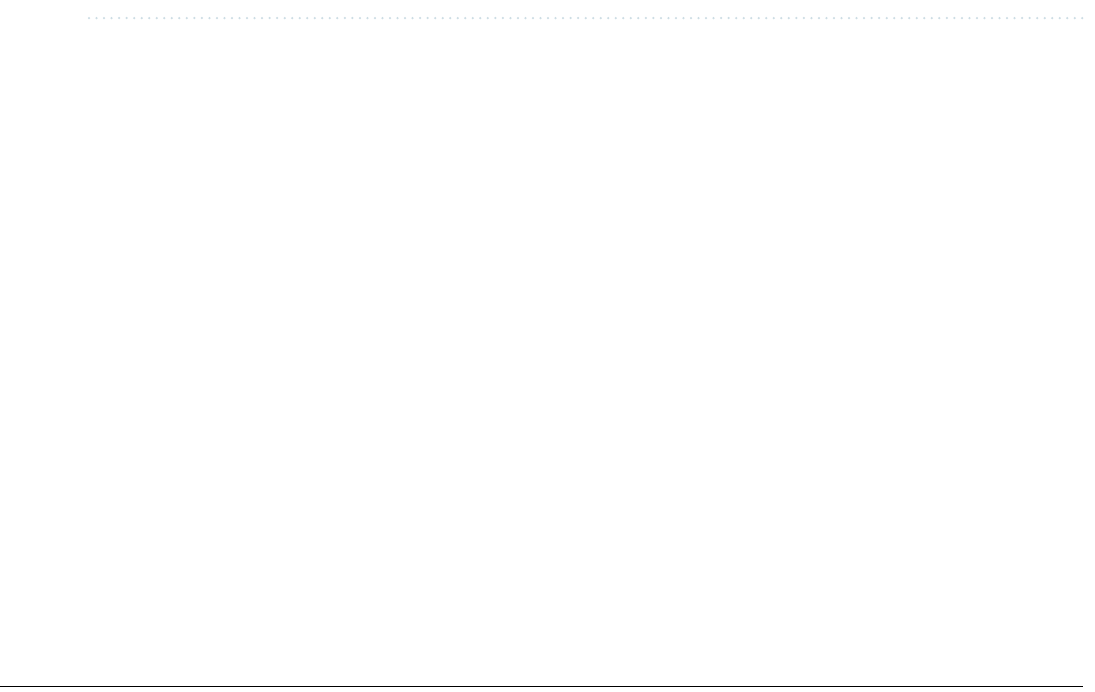
Table 7. HMH stresses and optimum topologies according to various load